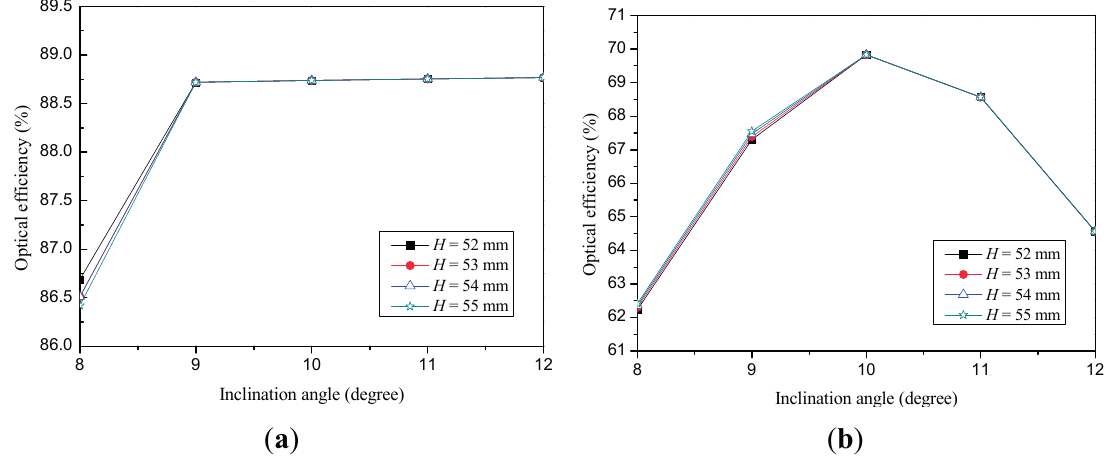
Figure 18. Optical efficiency for the Fresnel lens with SP-type SOE with various design values of H and θ . ( a ) under normal incidence; ( b ) incidence angle = 1°.